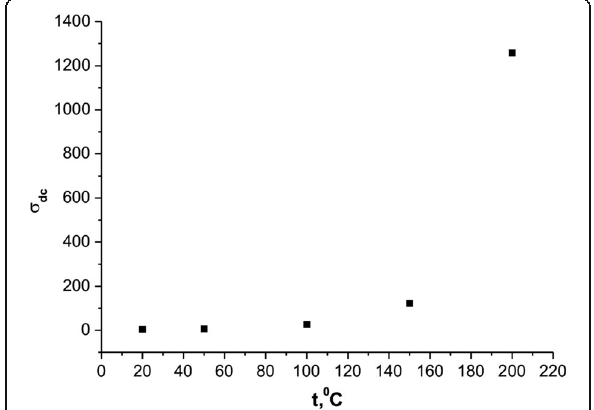
Fig. 12 The temperature dependence of conductivity synthesized systems